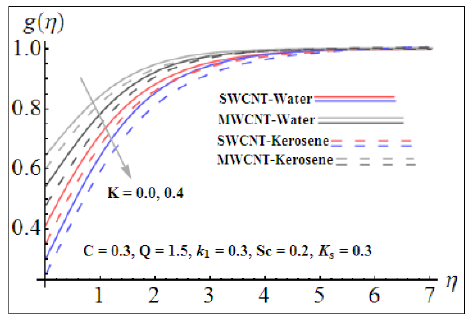
Figure 9. Behavior of θ ( η ) for increased values of ϕ .